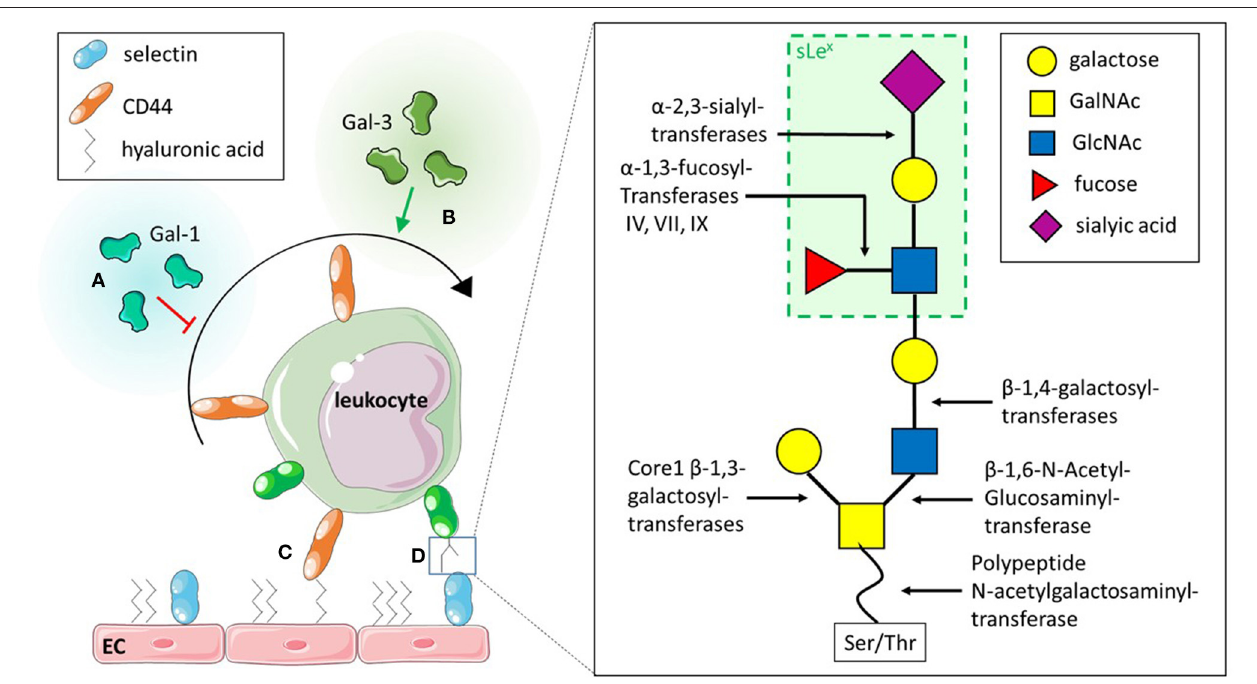
FIGURE 3 | Role of glycans and glycan binding proteins in leukocyte capture and rolling. (A) Exogenous Galectin (Gal)-1 inhibits capture and rolling of leukocytes. (B) Exogenous Gal-3 on the other hand promotes capture of leukocytes. (C) CD44 on leukocytes and the glycosaminoglycan hyaluronic acid on the endothelial cell (EC) surface interact to contribute to leukocyte capture. (D) Selectins are glycan binding proteins which bind to specific O-glycan structures such as sLe x . These glycan structures are formed through a multitude of enzymes which catalyse the addition of different carbohydrates to the glycan precursor.